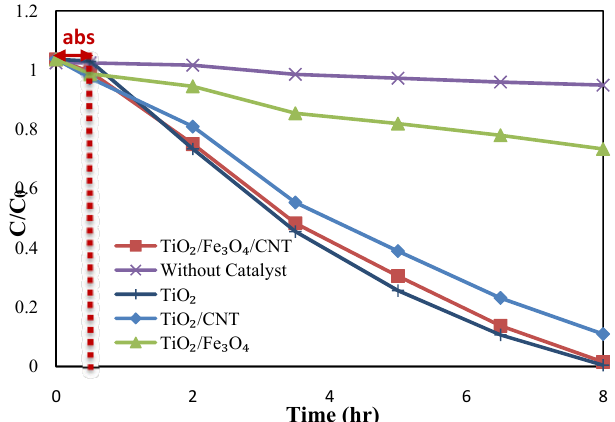
Fig. 17. Investigate of removal efficiency acid red 14 under sunlight Nanocomposite dosage = 0.5 g/L, dye concentration = 50 ppm, DO = 7/4 mg/L, pH= 7)